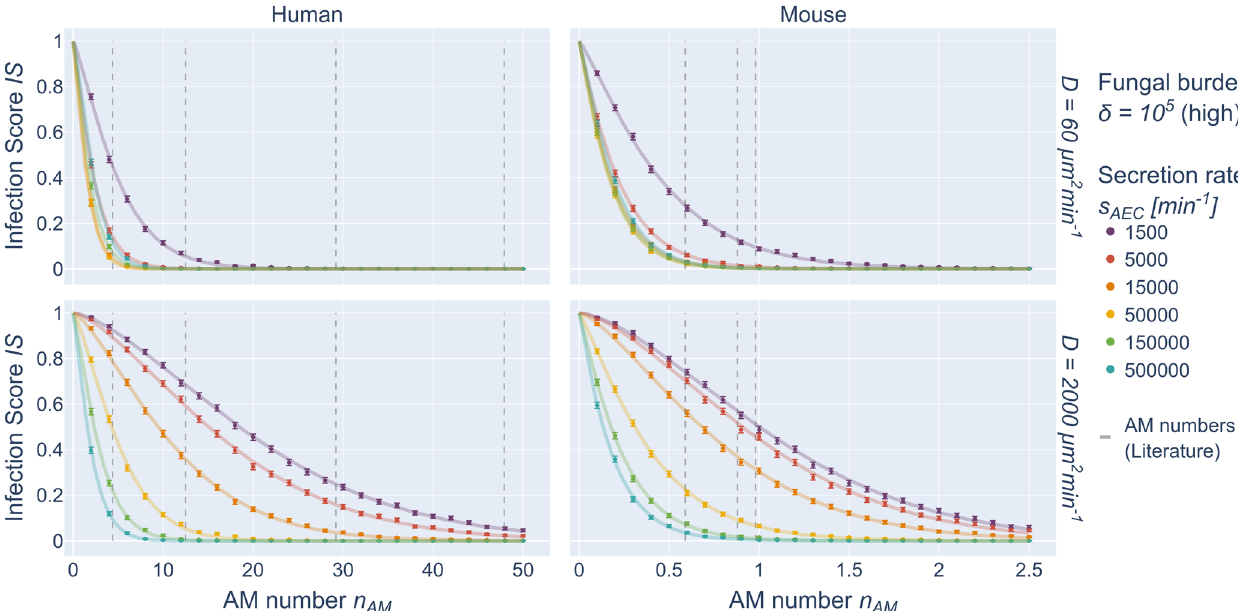
Fig. 4 hABM simulation data and SIM predictions for high fungal burden. Simulated data from the hABM are shown as points for high fungal burden in the human (left) and murine (right) system for D = 60 µm 2 /min (top row) and D = 2000 µm 2 /min (bottom row). Error bars represent the 95% con fi dence interval as obtained from the standard error of independent Bernoulli trials. Solid lines represent the fi t to the data points as obtained by the compressed exponential function (CEF). Dashed vertical lines denote AM numbers from